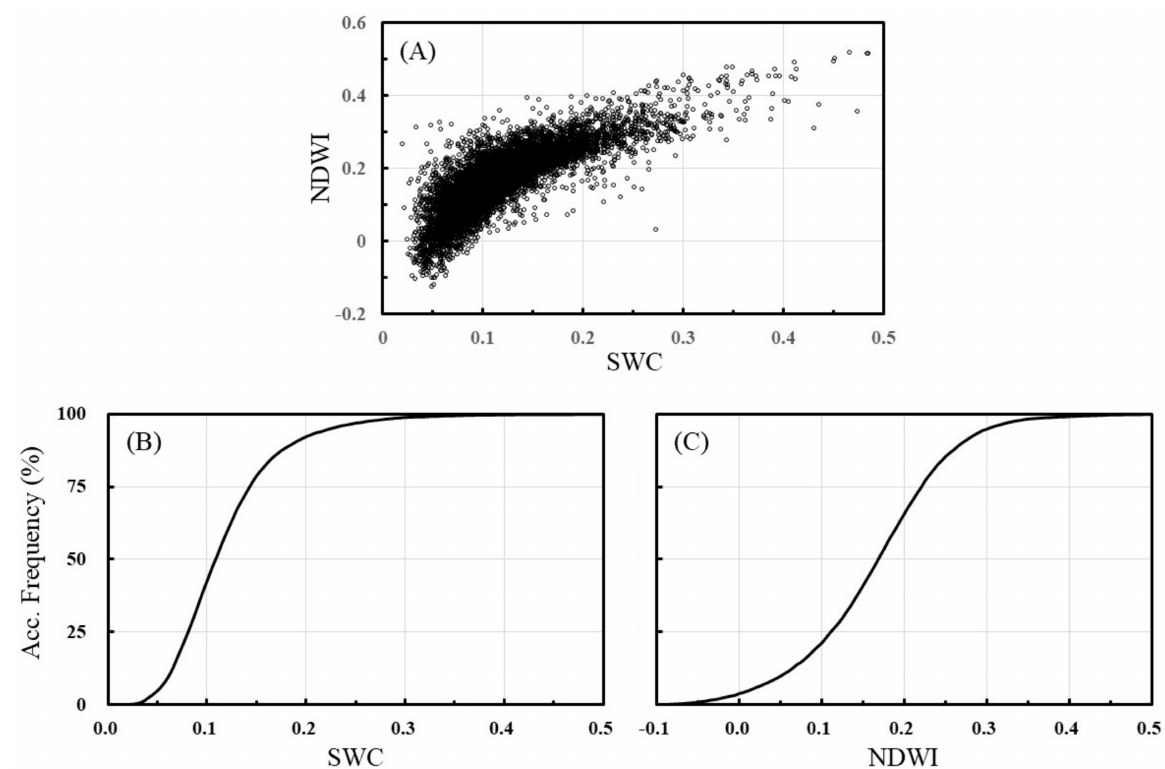
Figure 3. Relationships between SWC and NDWI ( A ) and accumulated frequency distributions of SWC ( B ) and NDWI ( C